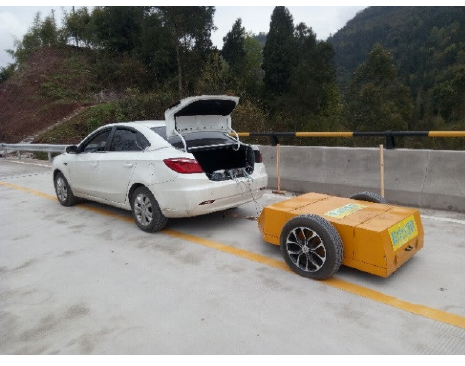
Figure 20. Hong Xing Bridge of Chongqing City.